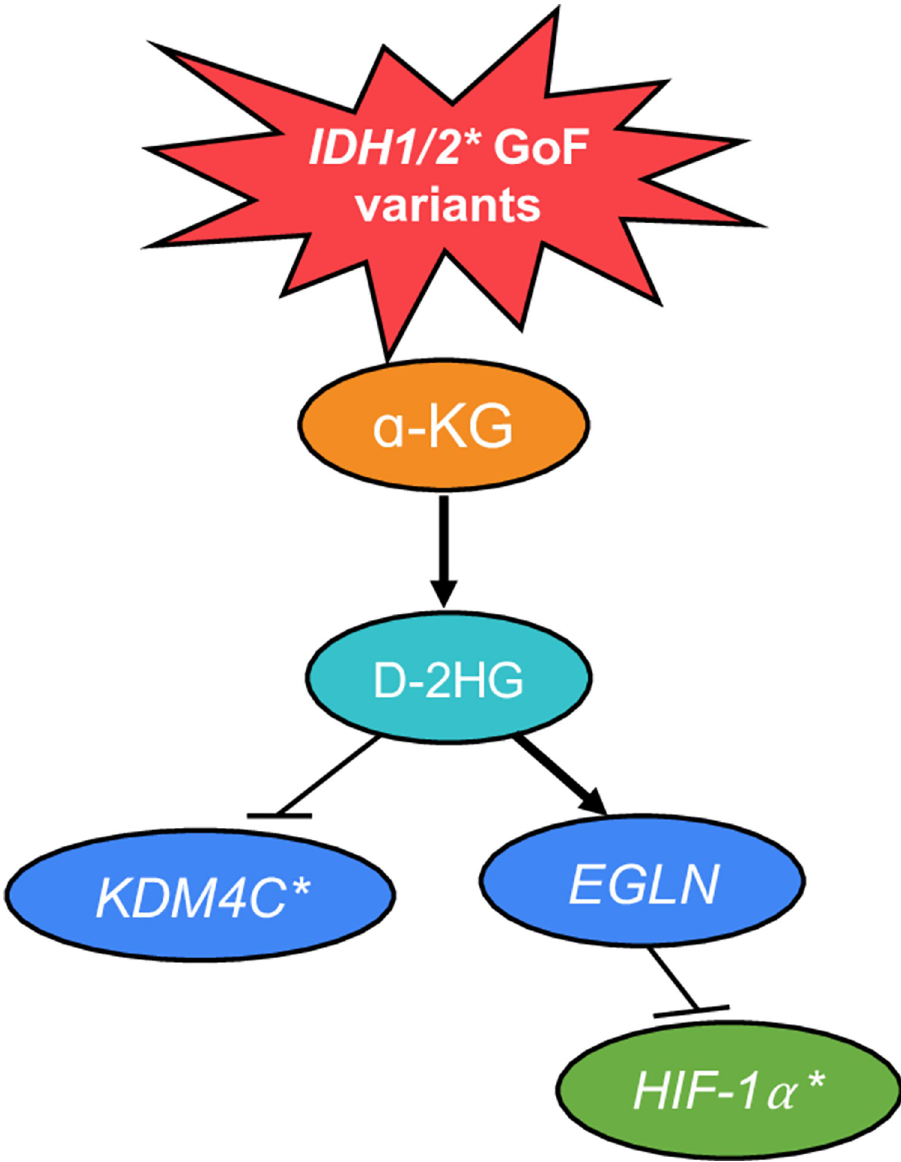
Fig 1. Effect of GoF IDH1 and IDH2 variants on KDM4C and HIF-1 α . � Asterisks denote genes found mutated in probands with OD or MS in this